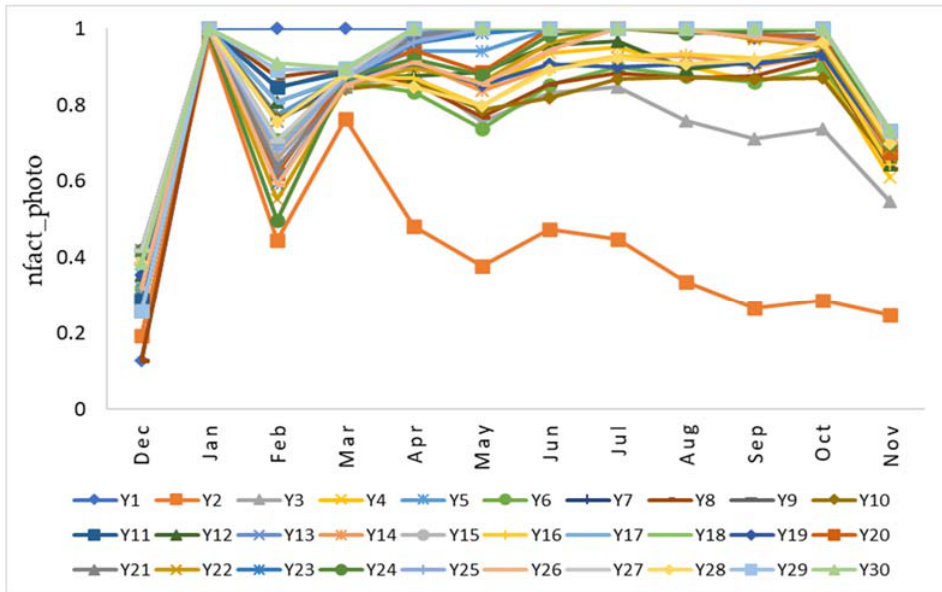
Figure 5. APSIM simulated nitrogen stress factor (1 = no stress and 0 = full stress) for photosynthesis ( nfact_photo ) under S1 soil type under Ir conditions across 30 simulated years from 1980–2010. Each Y no. indicates 360 days of crop duration from planting date (November 28) to the harvesting date.